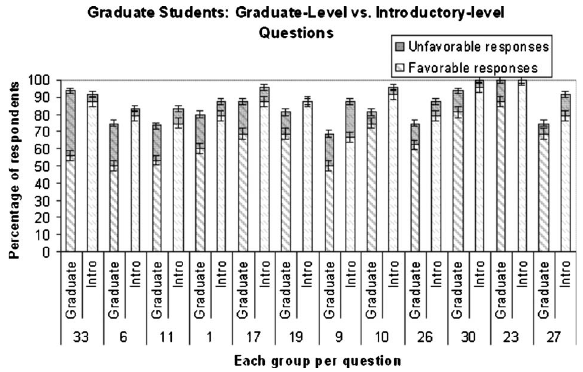
Table I (cid:4) . One introductory student stated in an interview that he feels frustrated with his incorrect problem solution and feels satisfied when he gets a problem right, which motivates him to continue to do problem solving. Therefore, he likes easier problems.